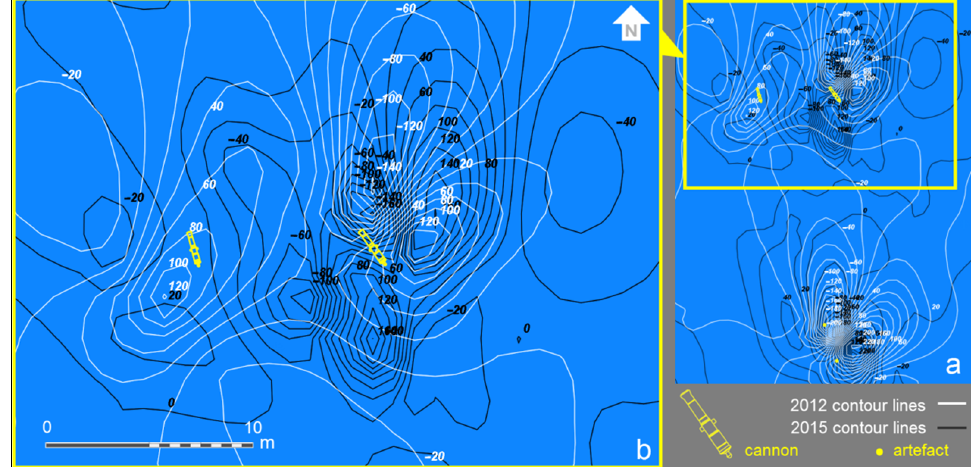
Figure 17. Contour line anomaly maps over wreck site 3 produced from datasets acquired in 2012 and 2015. The 2012 iso-contours are shown in semi-transparent white and the 2015 iso-contours are shown in dark grey. While the overall iso-contour patterns over the site are consistent ( a ) a high-gradient positive anomaly over the westerly cannon is found shifted by 10 m southeast, ( b ) implying possible cannon movement. Contour line interval: 20 nT.